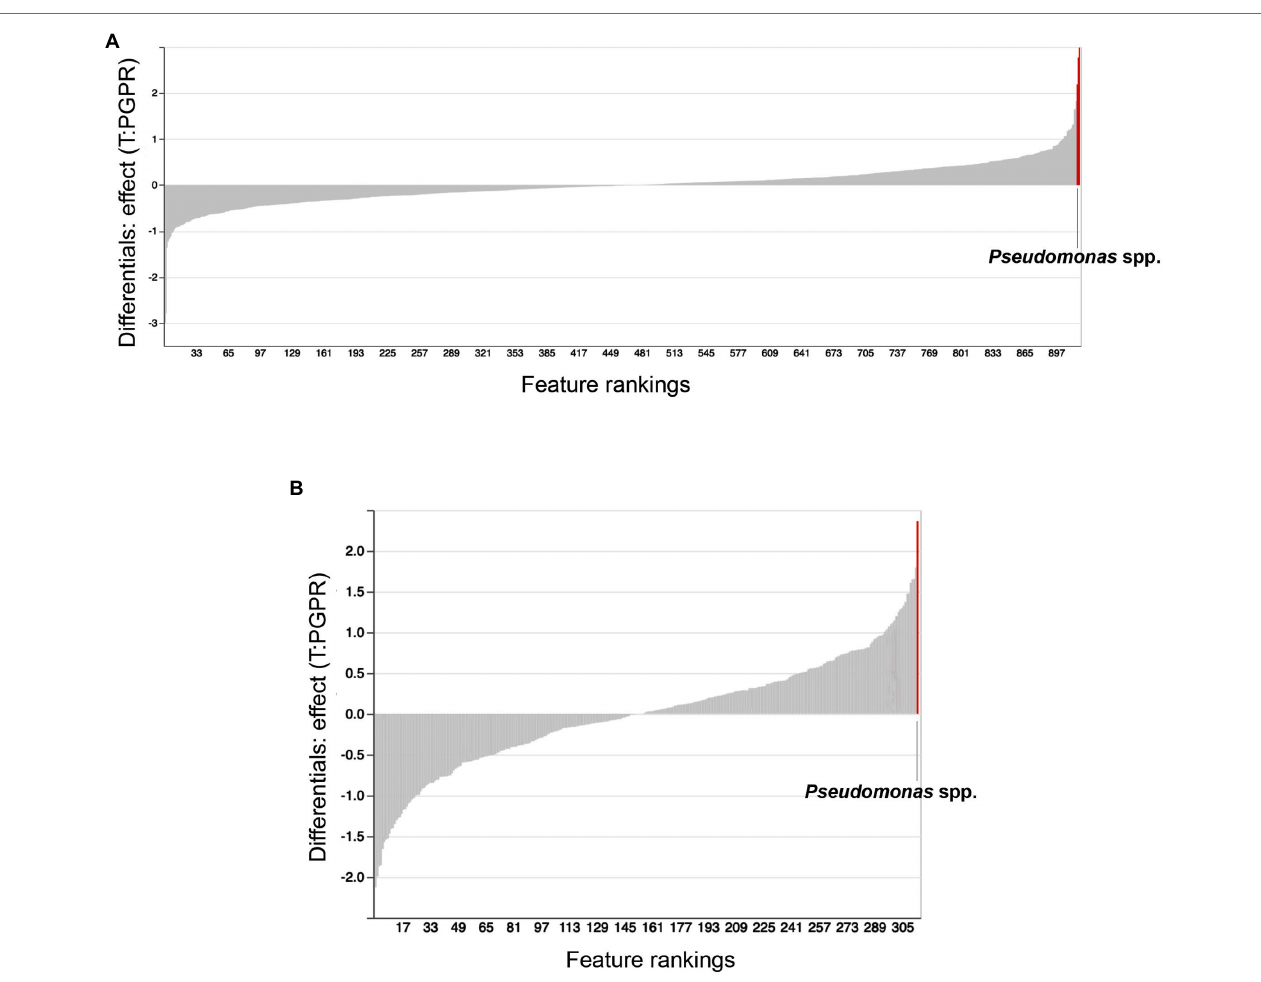
FIGURE 6 | Songbird feature rankings of bacteria to plant growth promotion. Songbird differentials ranked in Qurro plot for substrates (A) Promix and (B) Canna coco. Highest ranked bacteria are highlighted in red and identified in the